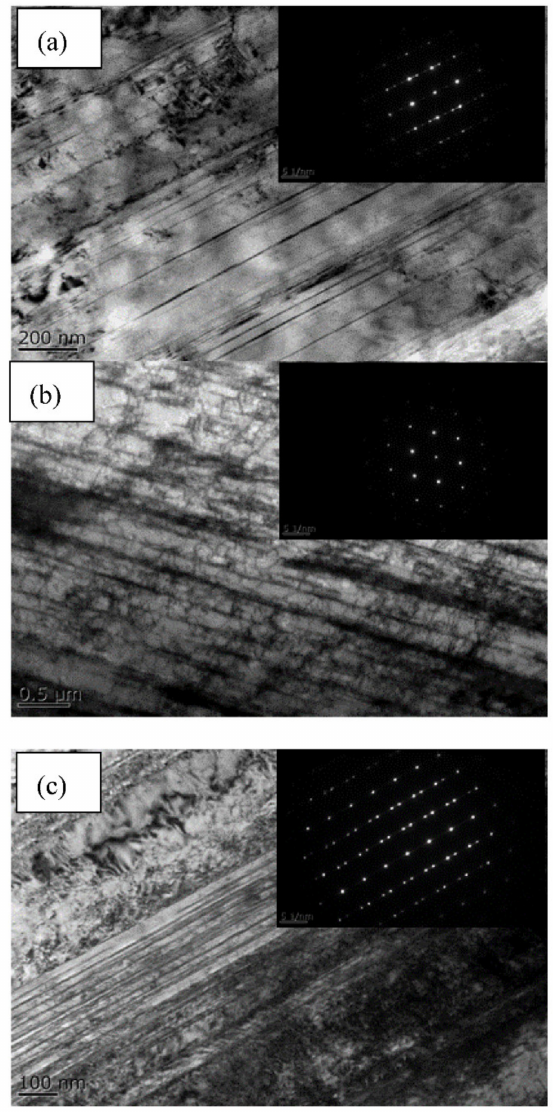
Figure 8. TEM images of deformation studied steels: ( a ) TWIP-ref deformed to 0.15; ( b ) 12CrN deformed to 0.15; and ( c ) 12CrN deformed to 0.45.